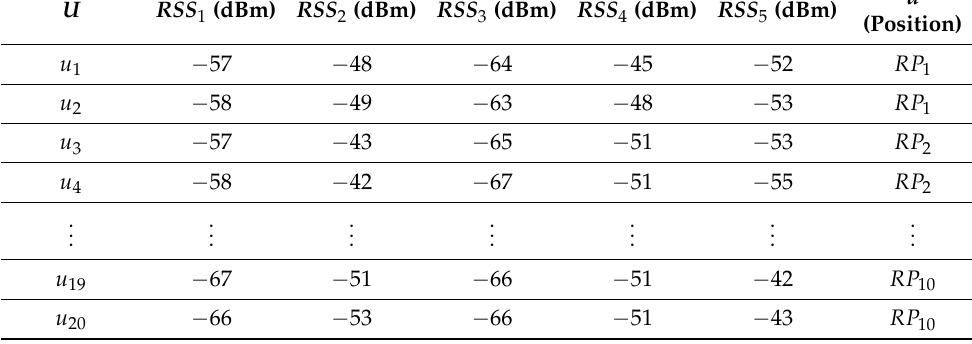
Table A2. The structure of the decision table created from the original RSS database.